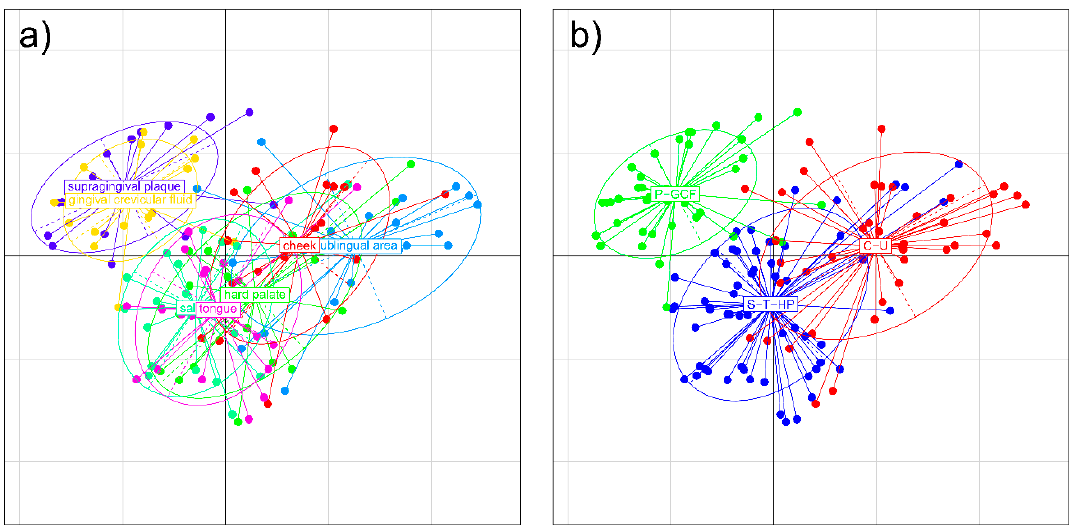
Figure 2. MDS plots of microbial profiles are given. ( a ) MDS plot for microbial profiles for all oral niches (plaque, gingival crevicular fluid, saliva, tongue, palate, cheek, sublingual) are displayed; ( b ) MDS plot of microbial profiles for defined metaniches (P-GCF = plaque/ gingival crevicular fluid, S-T-HP = saliva/tongue/palate, C-U = cheek/sublingual) are displayed.